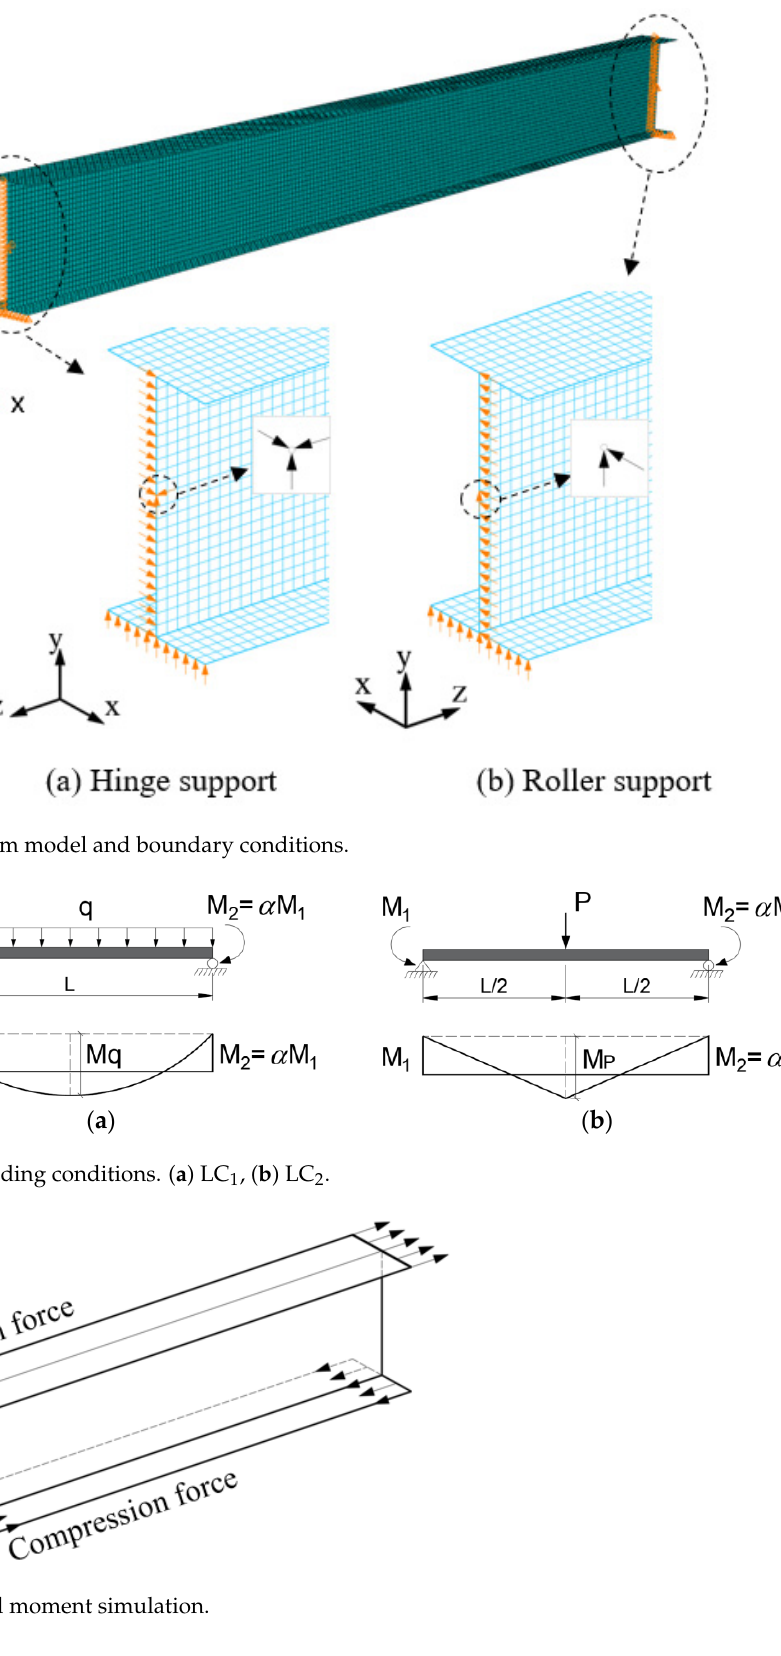
Figure 6. Typical buckling mode shapes. ( a ) M q(P) /M 1 > 1. ( b ) M q(P) /M 1 ≤ 1. Table 2 presents the elastic critical buckling strengths of these beams subjected to equal end moments. The data show that the elastic critical buckling strengths obtained in the FEA and Timoshenko and Gere’s study [29] are in very good agreement. Table 2. Comparison between Timoshenko and Gere’s study and FEA. L/h